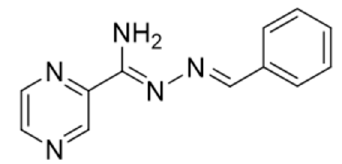
Figure 1. The structure of the organic ligand.